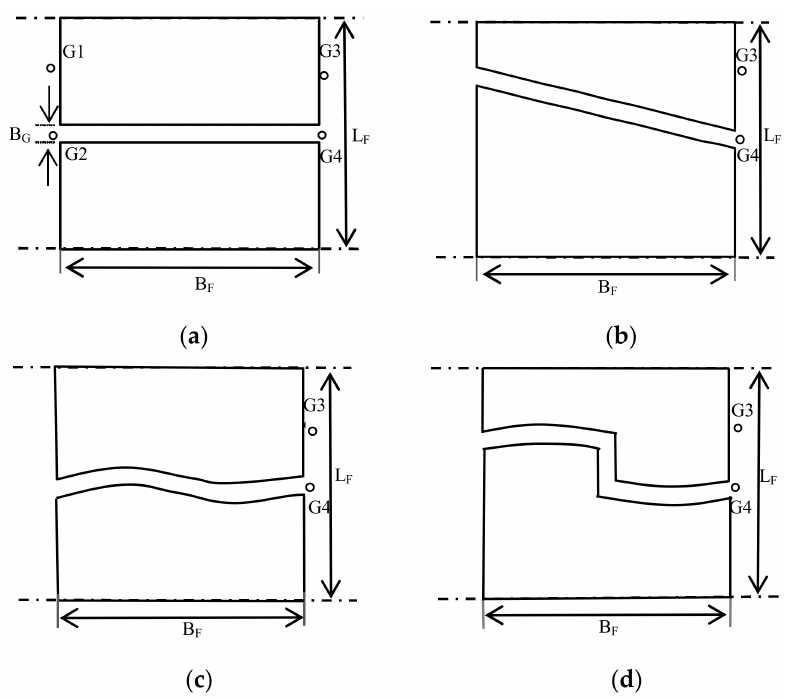
Figure 11. Sketch of gap arrangements, ( a ) Case 1, ( b ) Case 2, ( c ) Case 3, ( d ) Case 4.